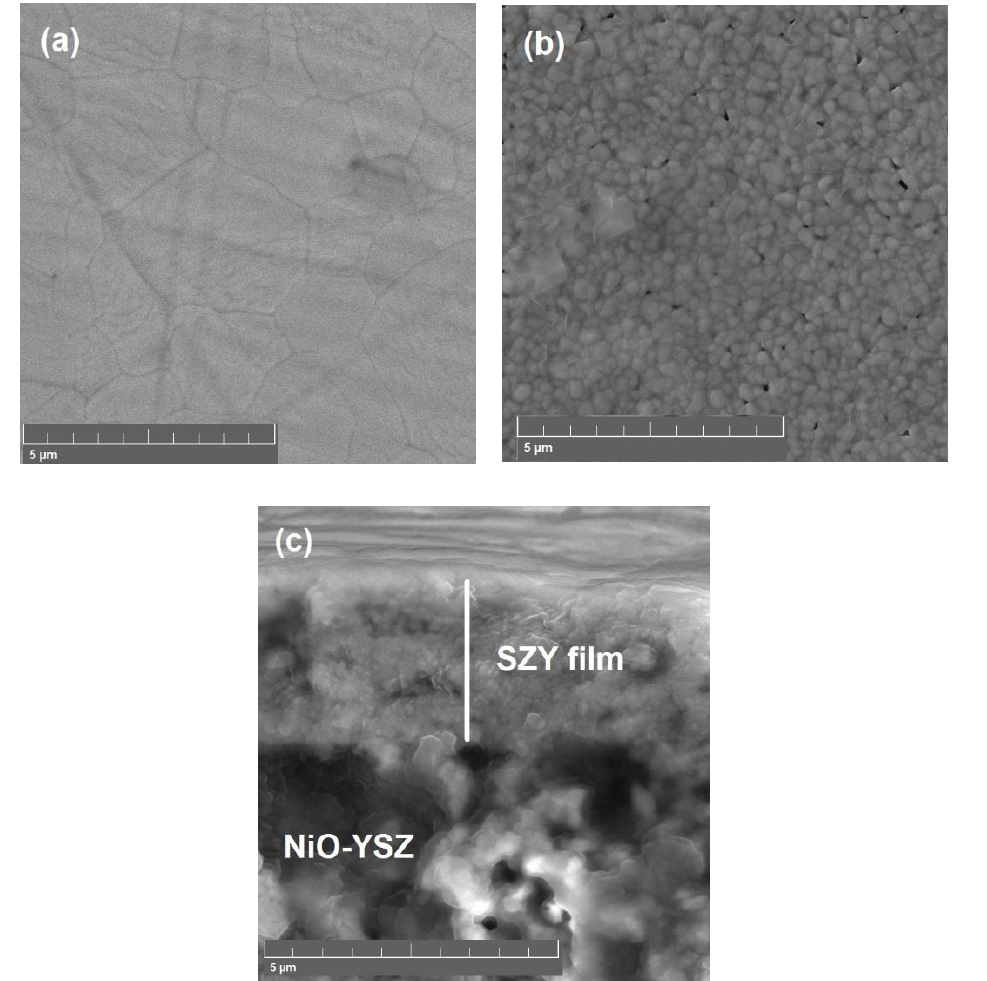
Figure 3. SEM images of the thermally etched surface of SZY pellet ( a ), surface ( b ) and fractured cross-section of NiO-YSZ supported SZY film ( c ).